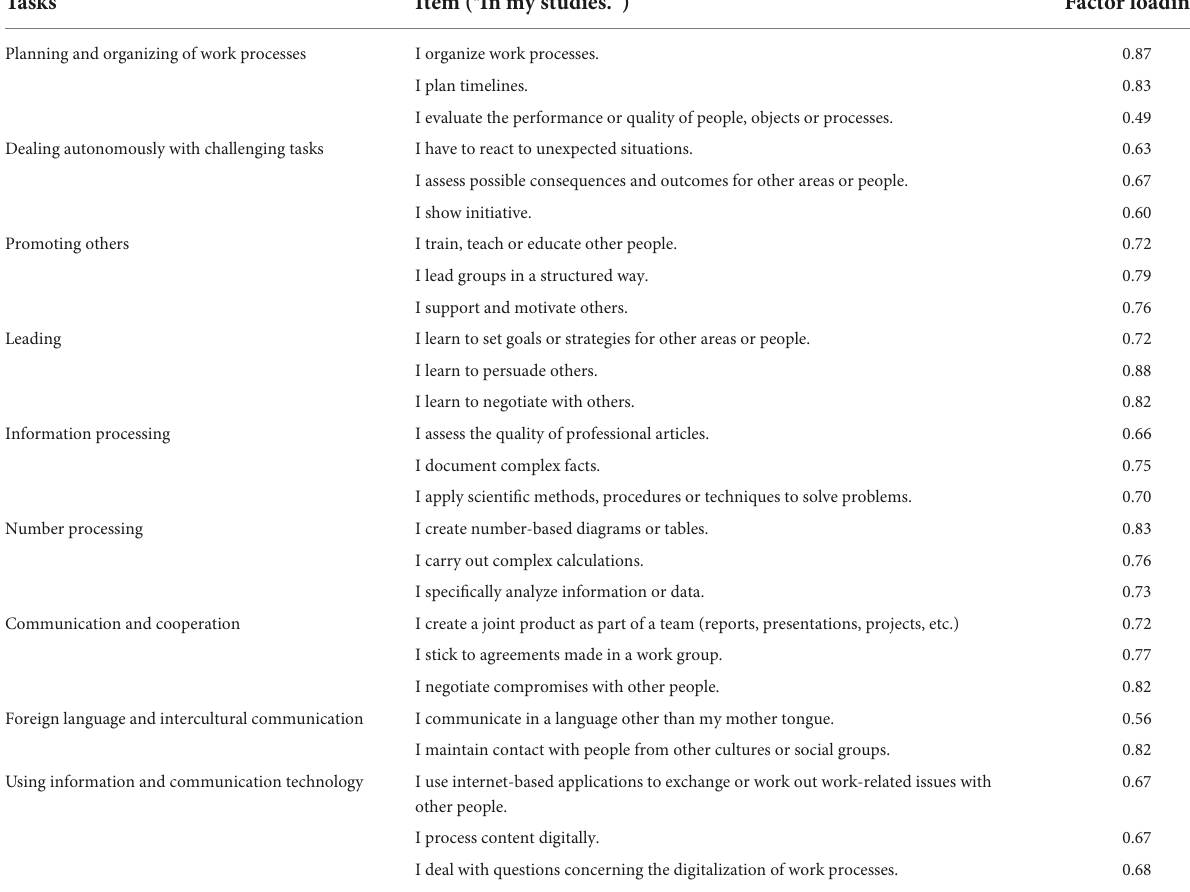
TABLE 4 Factor loadings for areas of generic learning opportunities (student data). Tasks Item ( “ In my